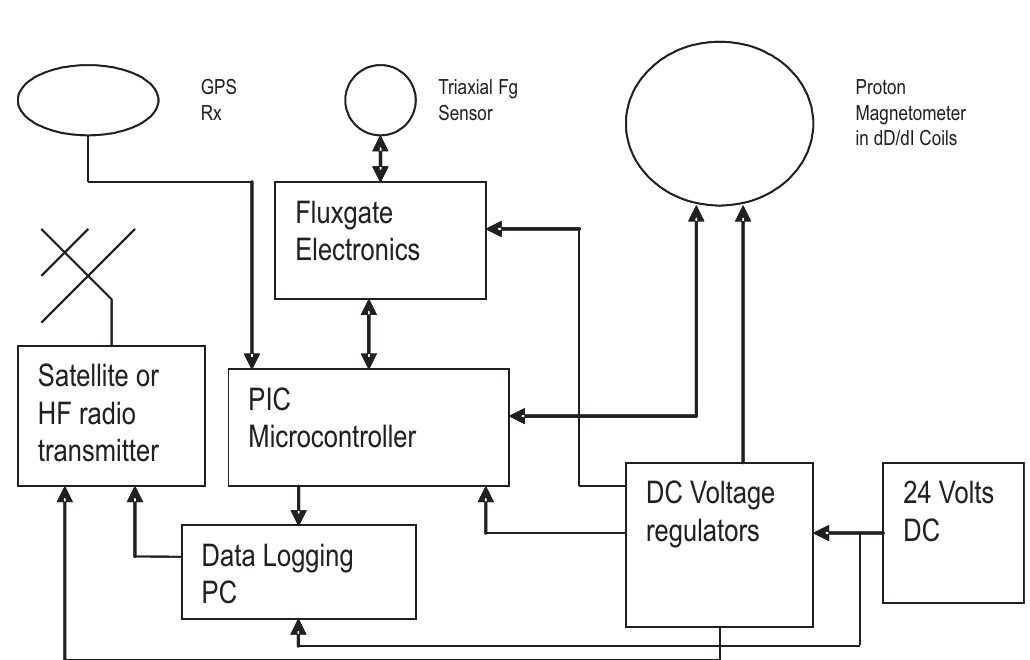
Fig. 2. Block diagram of the new